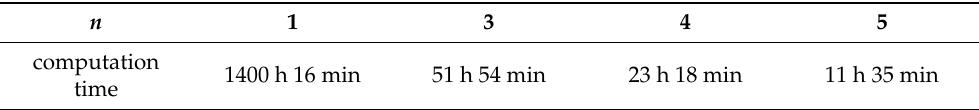
Table 4. The estimated computation time of penetration simulations on target U-2 under different amplification